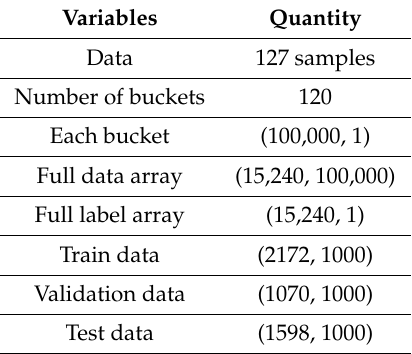
Table 4. Statistical time-domain